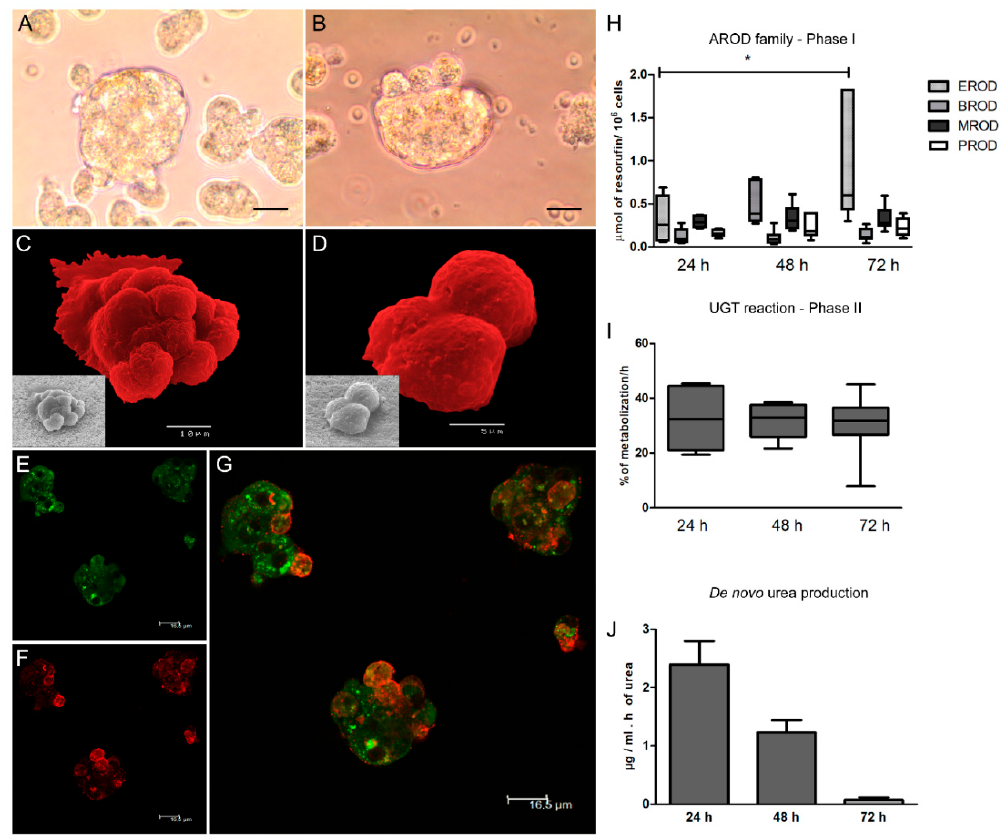
Figure 1. Morphological and metabolic characterization of the hepatic spheroids. Samples of hepatocytes cultured in a 3D-system for 72 h were observed under an inverted microscope ( A , B ), (scale bar 20 µ m, 400 × magnification) and scanning electron microscope ( C , D ) (scale bar 10 µ m and 5 µ m, respectively). ( C , D ) Images were artificially colored to evidence cell morphology. Cellular aggregates exhibit a smooth membrane bound by an extracellular matrix generated by cells. Spheroids stained for actin (green) ( E ) and ferritin (red) ( F ) were observed under a fluorescent confocal microscope, and images were acquired. ( G ) represents the overlapping of actin ( E ) and ferritin ( F ) staining (Scale bar 16.5 µm for E, F and G images). Hepatic spheroids with diverse levels of complexity and nearly complete cell fusion can be observed. Nuclei—black spots; actin network—green; ferritin—red. The enzymatic activity of 7-ethoxyresorufin (EROD), 7 benzyloxyresorufin (BROD), 7-methoxyresorufin (MROD), 7-pentoxyresorufin (PROD) ( H ) of the phase I alkoxyresorufin O-dealkylation (AROD) family, and UGT ( I ) of phase II represented by box plots, whiskers (minimum to maximum), and urea de novo production ( J ), expressed by the mean and standard error, were evaluated at 24, 48, and 72 h of 3D-hepatocyte culture. Results of 10 dogs and three replicates per sample are represented. The non-parametric Wilcoxon matched-pairs signed-rank test was applied for statistical comparisons, and * indicates statistical significance values ( p < 0.05).